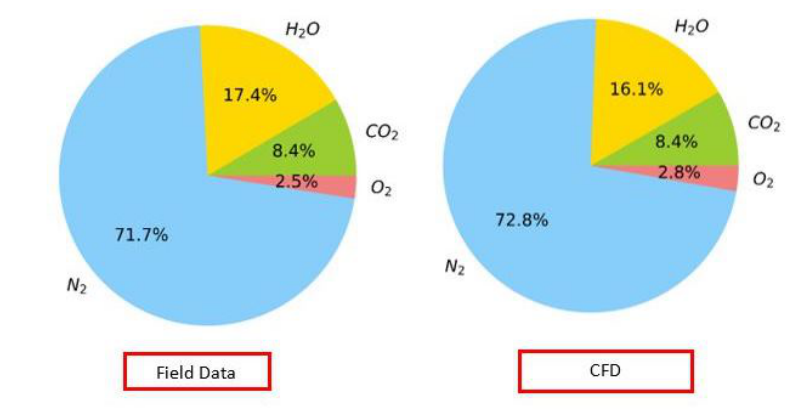
Figure 11. Composition of combustion